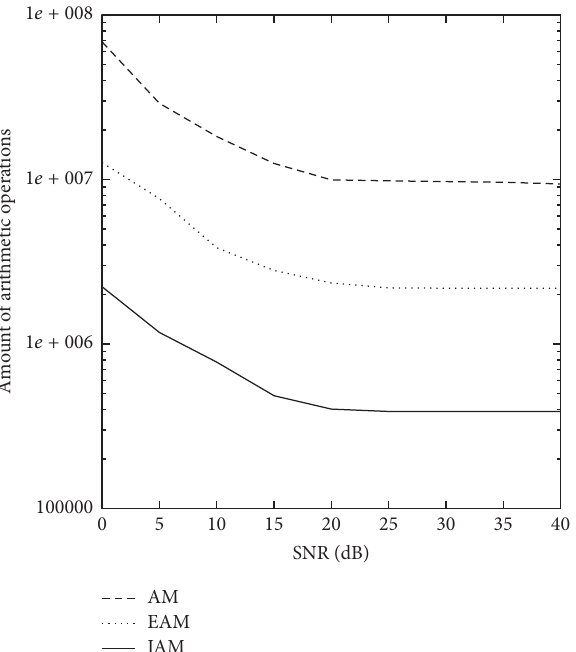
Figure 5: Average amount of operations for AM, EAM, and IAM algorithms. 𝑝 = 8 , 𝑞 = 5 , 𝜂 = 3